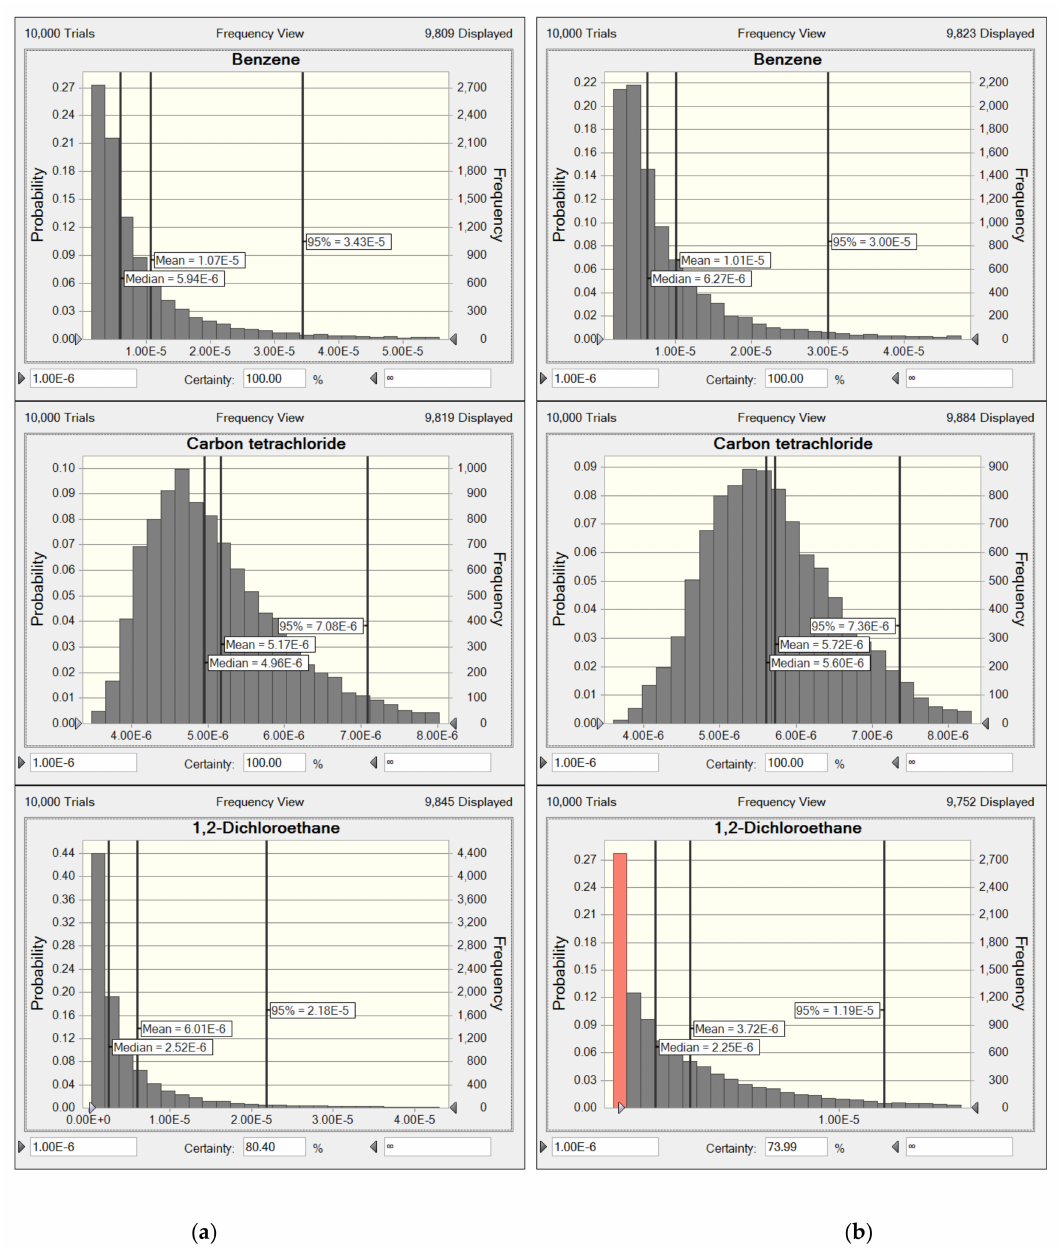
Figure 7. Probability distribution of cancer risks of selected VOC species during ( a ) P1 and ( b )